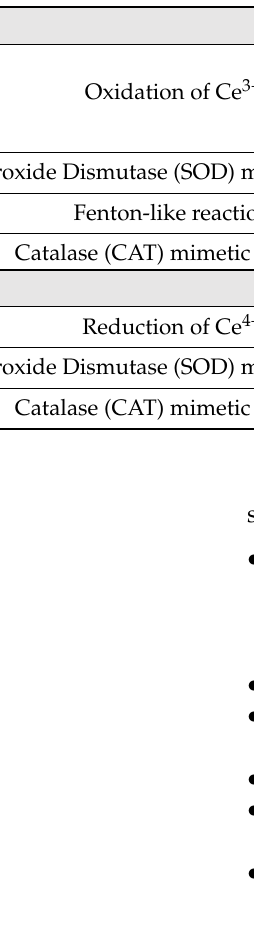
Table 4. Different redox reactions of cerium (ROS in